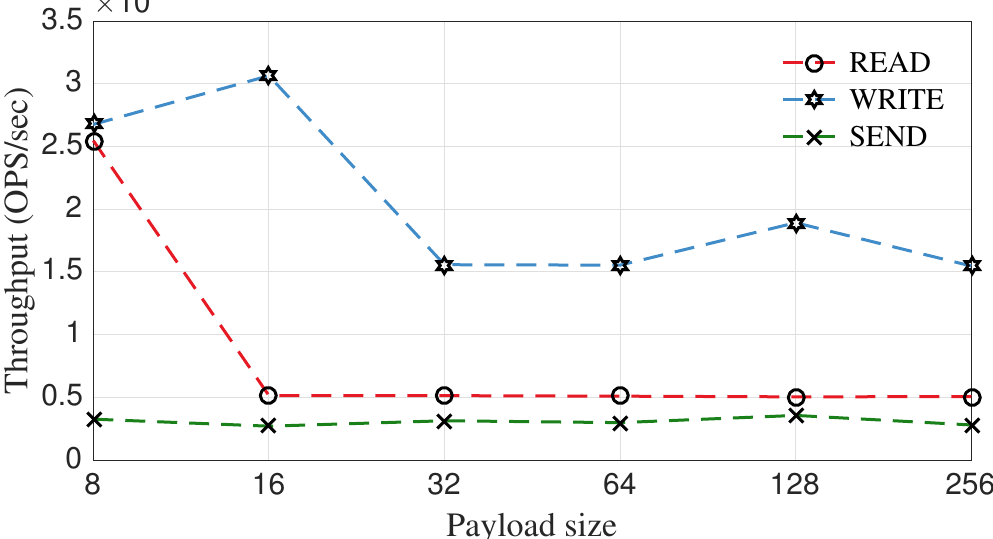
Figure 6. Payload size impact on performance.